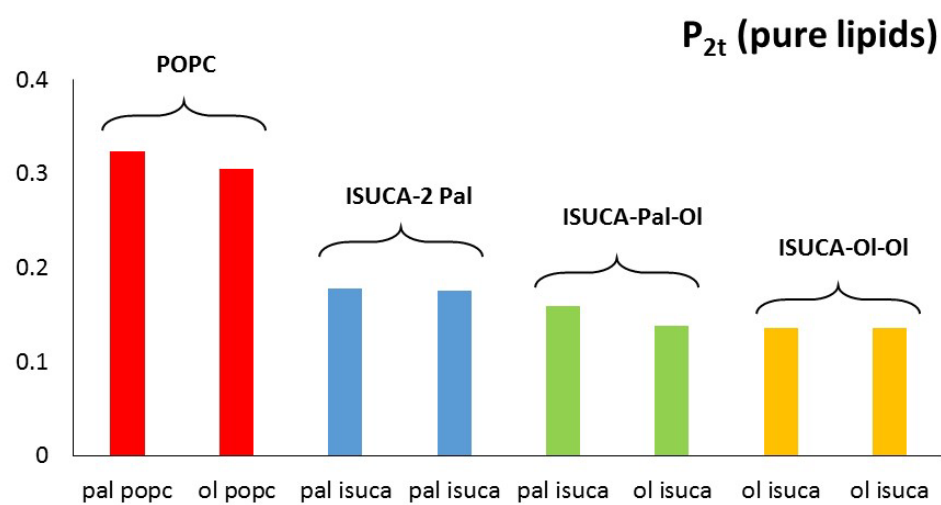
Figure 6. P 2t for pure lipids: pal = palmitic hydrocarbon chain, ol = oleic hydrocarbon chain.